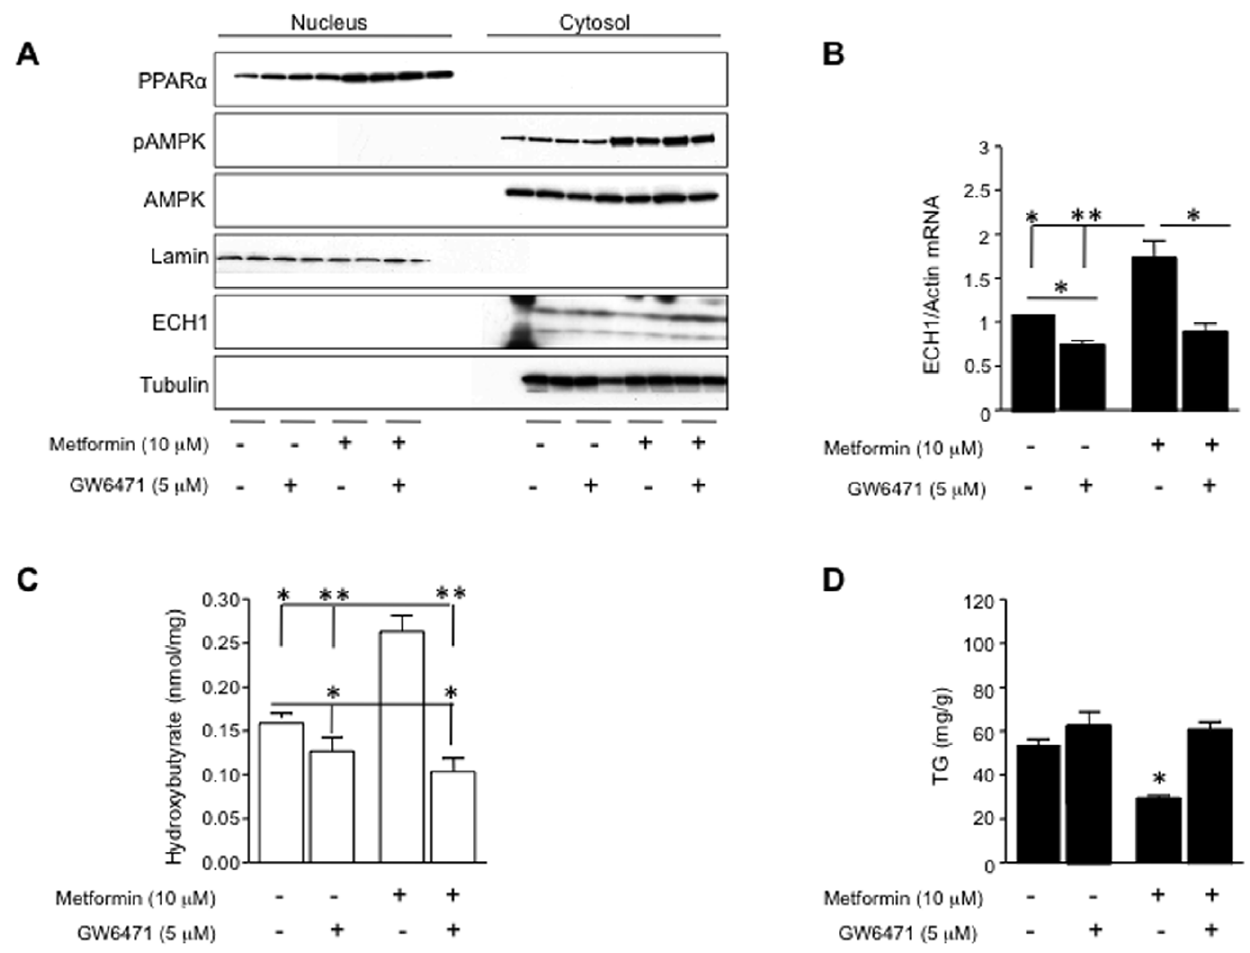
Figure 2. Metformin-induced up-regulation of ECH1 is mediated by PPAR a . A) Representative western blot of nuclear and cytosolic extracts from hepatocytes exposed to metformin (10 m M) and the PPAR a inhibitor, GW6471 (5 m M). As shown, GW6471 reduces metformin-induced ECH1 up- regulation in the cytoplasmic fraction but do not affet either PPAR a nuclear expression or AMPK phosphorylation. B) ECH1 mRNA levels in hepatocytes exposed to metformin (10 m M) and the PPAR a inhibitor, GW6471 (5 m M) C) Inhibition of PPAR a activity with the antagonist GW6471 reduces metformin-induced fat oxidation. D) Inhibition of PPAR a activity with the antagonist GW6471 reduces metformin-induced trigyceride accumulation. *p , 0.05, **p , 0.01.